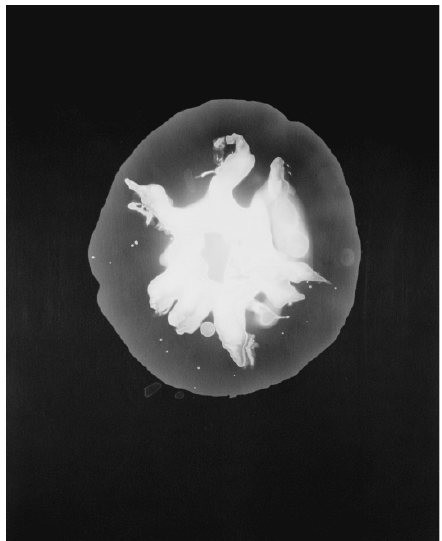
Fig. 4. Susanne Ramsenthaler. From the series Bloom . Photogram on silver gelatin